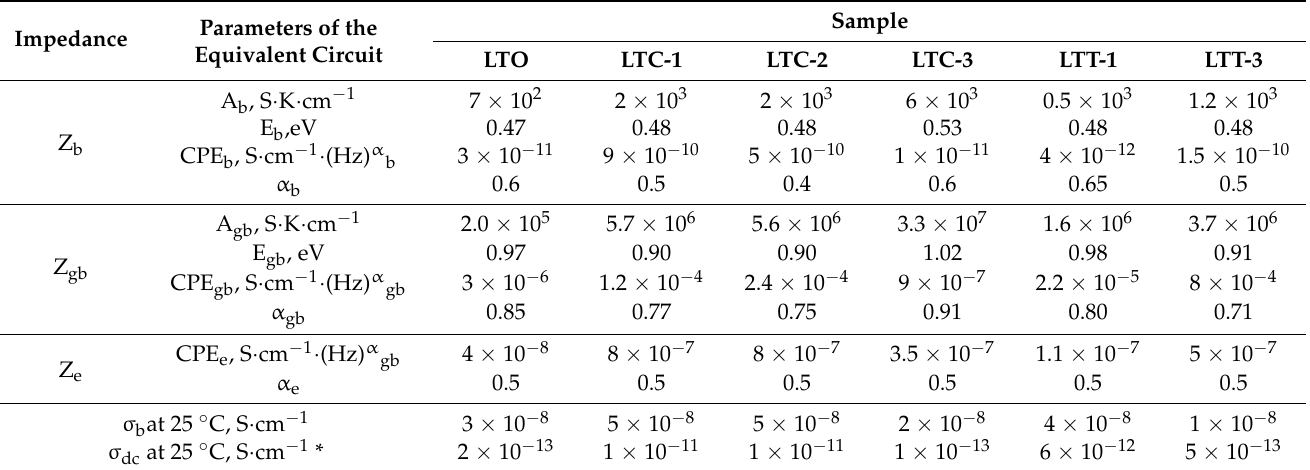
Table 2. Numerical values of the equivalent circuit parameters obtained by